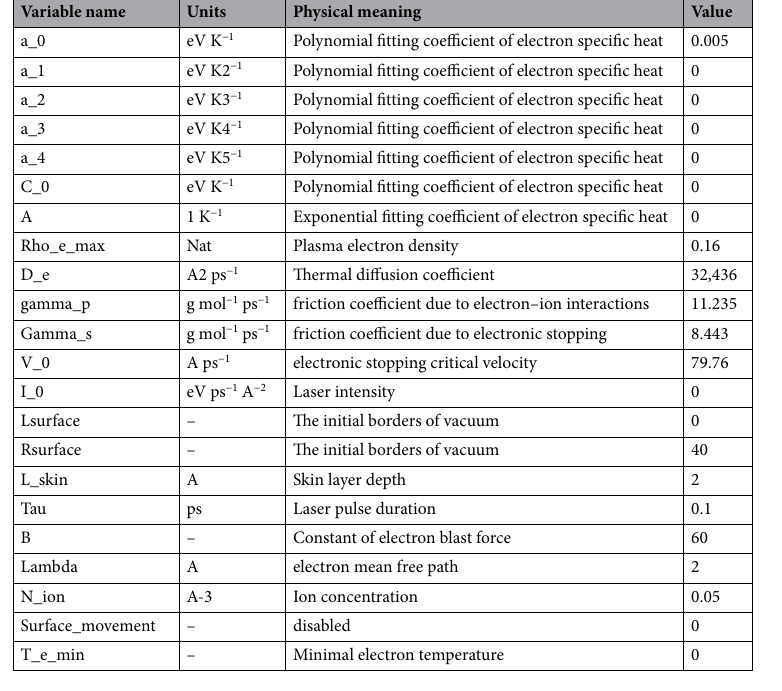
Table 1. Parameters for TTM